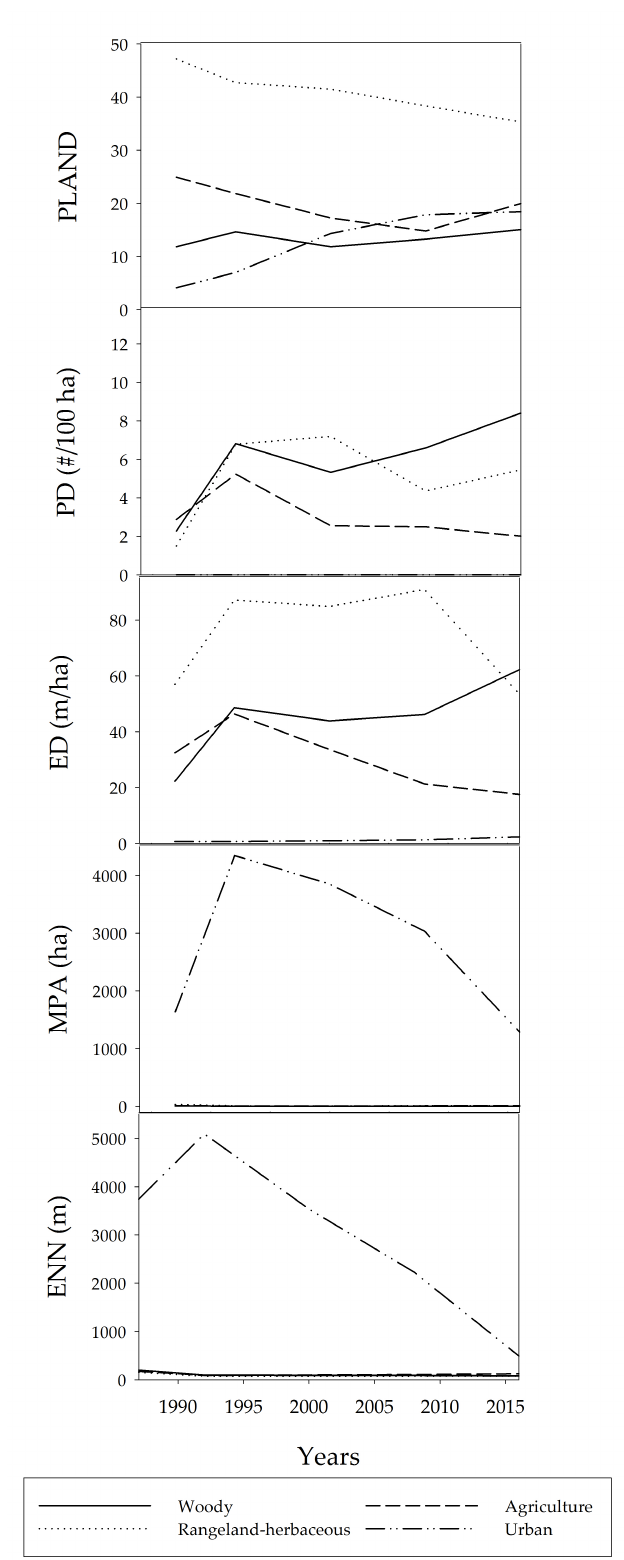
Figure 3. Percentage of landscape (PLAND; %), patch density (PD; # patches / 100 ha), edge density (ED; m / ha), mean patch area (MPA; ha), and Euclidean distance to nearest neighbor patch (ENN; m) for woody, rangeland-herbaceous, agriculture, and urban cover types from 1987 to 2016 in the Rio Grande Delta and surrounding rangeland study area (10,065 km 2 ) in South Texas, United